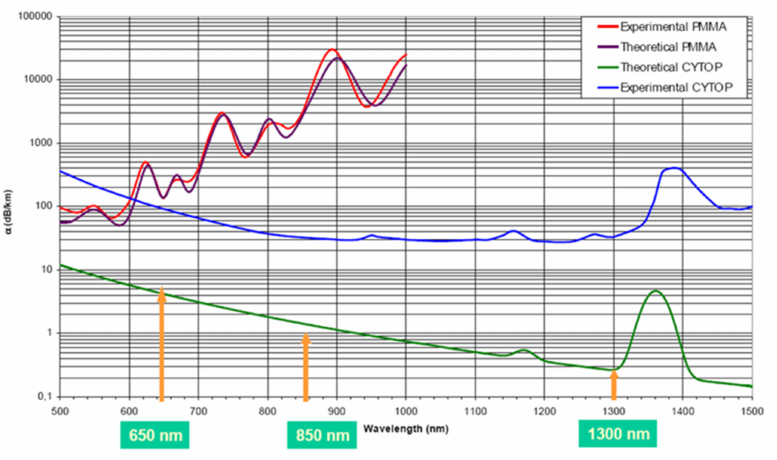
Figure 3. Spectral attenuation of the graded-index POF. Reproduced with permission Ref. [69].